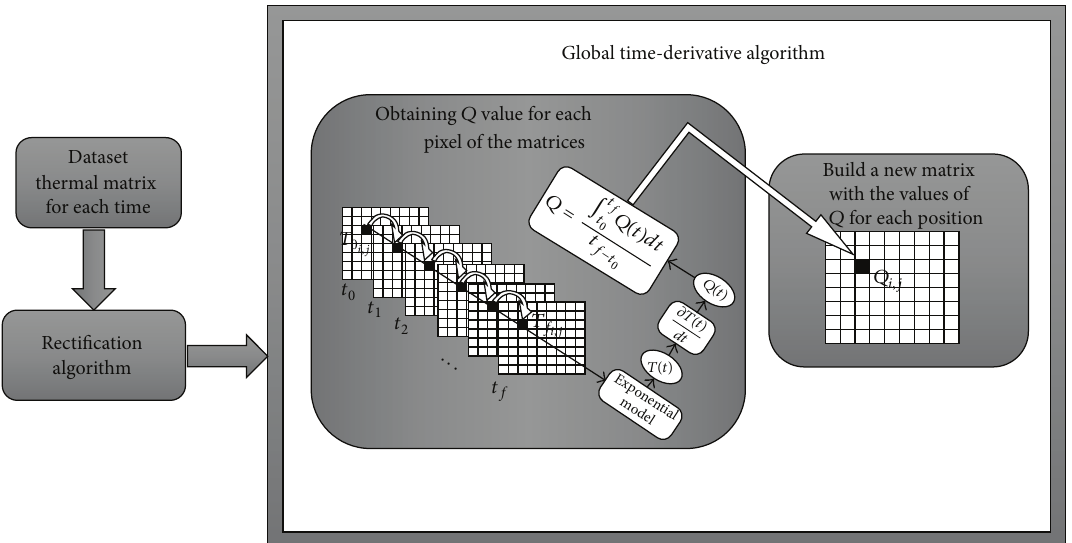
Figure 3: Steps followed by the global time-derivative algorithm. After data acquisition and rectification, the exponential model is applied for each ( 𝑖, 𝑗 ) position with the values of temperature for each time instant. As a result, a temperature function is obtained and the time derivate of the temperature function is the cooling function, which is averaged for each position of the matrix, obtaining a matrix of cooling